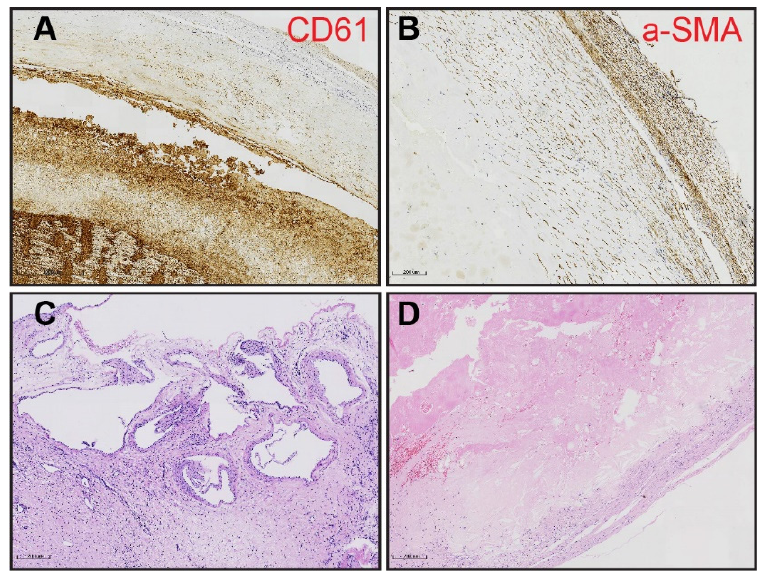
Figure 1. Four basic lesions on the pulmonary vascular bed of CTEPH patients. ( A ) Thrombotic lesions indicated by CD61. ( B ) Neointima formation marked by α -SMA. ( C,D ) Atherosclerosis plaque ( C ), and recanalized obstructive lesion ( D ) showed by HE staining. Scale bar = 200 μ m.